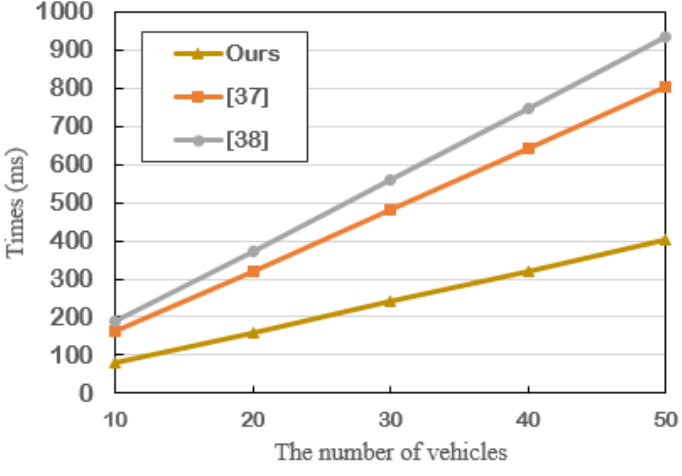
Figure 4. The time cost of signature verification of different